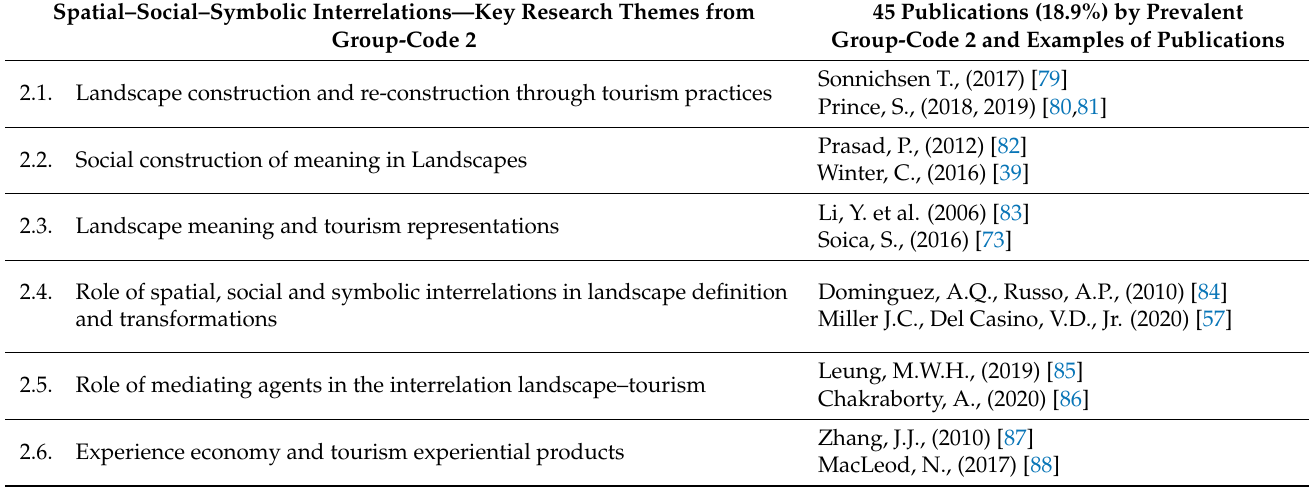
Table 4. Group-Code 2—Number of articles by prevalent key theme and examples of publications.